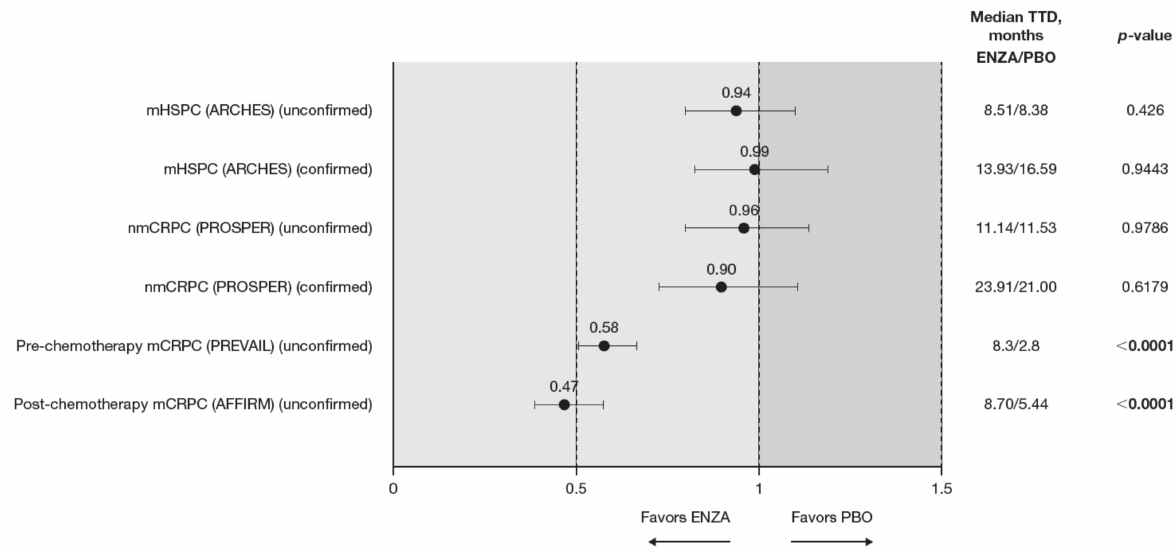
Figure 2. PCS − Pain FACT-P subscale score time to deterioration. To meet criteria for “confirmed” time to first deterioration, the initial (unconfirmed) report of deterioration had to be verified at the next consecutive study visit. Abbreviations: ENZA: Enzalutamide; mCRPC: Metastatic castration-resistant prostate cancer; mHSPC: Metastatic hormone-sensitive prostate cancer; nmCRPC: Non-metastatic castration-resistant prostate cancer; PBO: Placebo; PCS: Prostate Cancer Subscale of the FACT-P; TTD: Time to